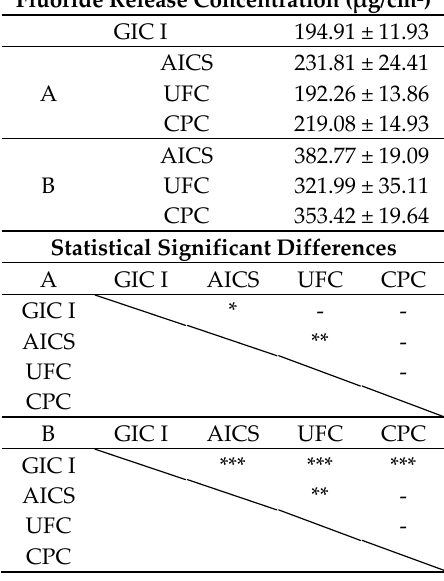
Table 5. After five days, the accumulated amounts of fluoride ions (per unit sample surface area) released from samples prepared using the two conditions in Experiment I and the results of statistical analyses. ( n = 5/group).